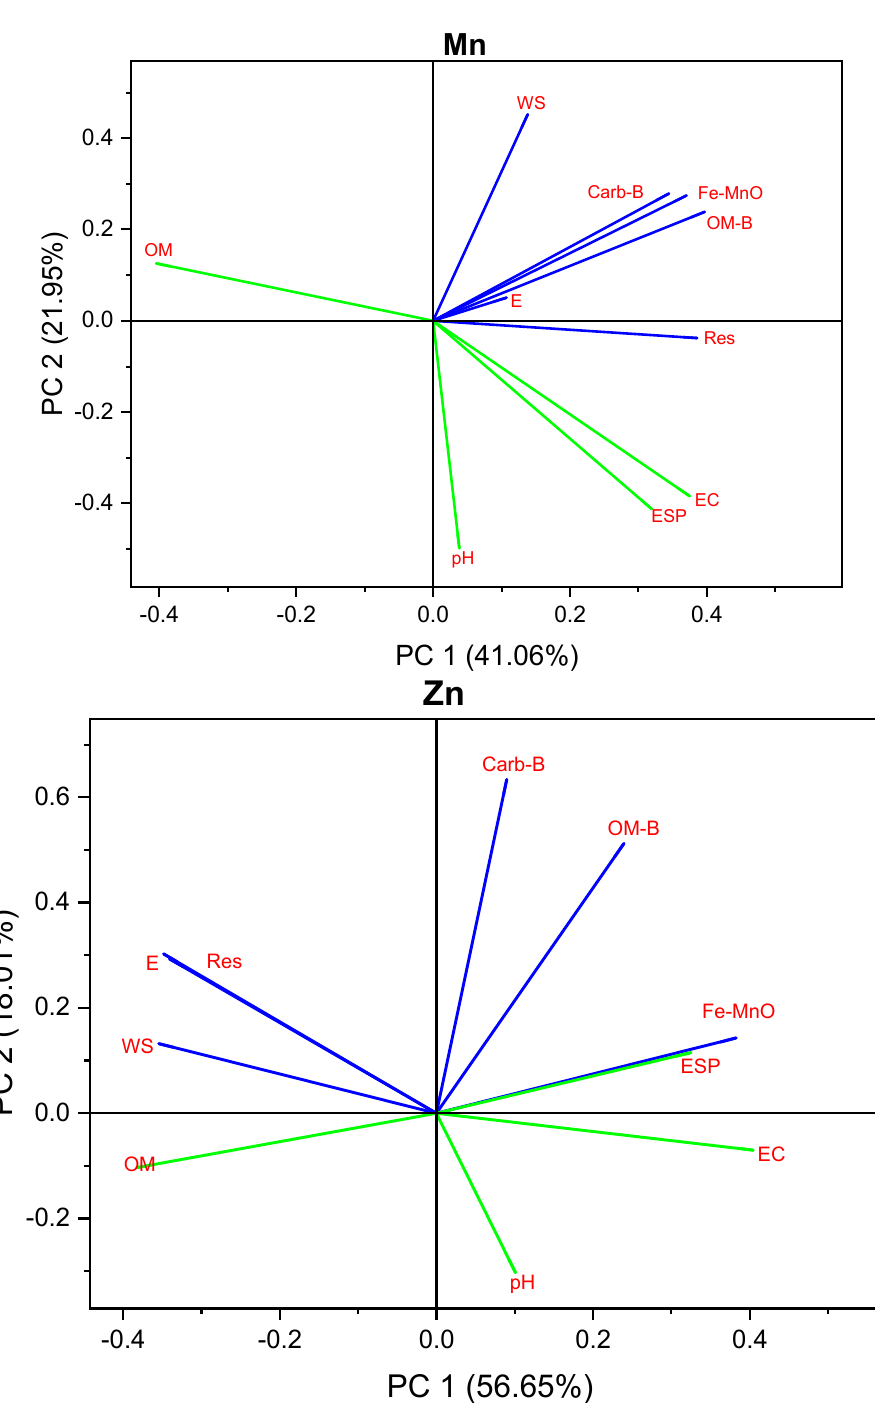
Figure 5. Biplot of the first two principal components from PCAs for micronutrient fractions and other soil parameters (OM and pH).